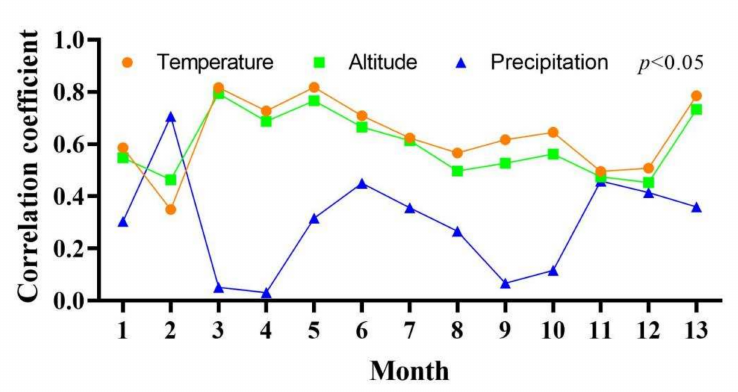
Figure 10. Correlation of ET with temperature, altitude and precipitation.